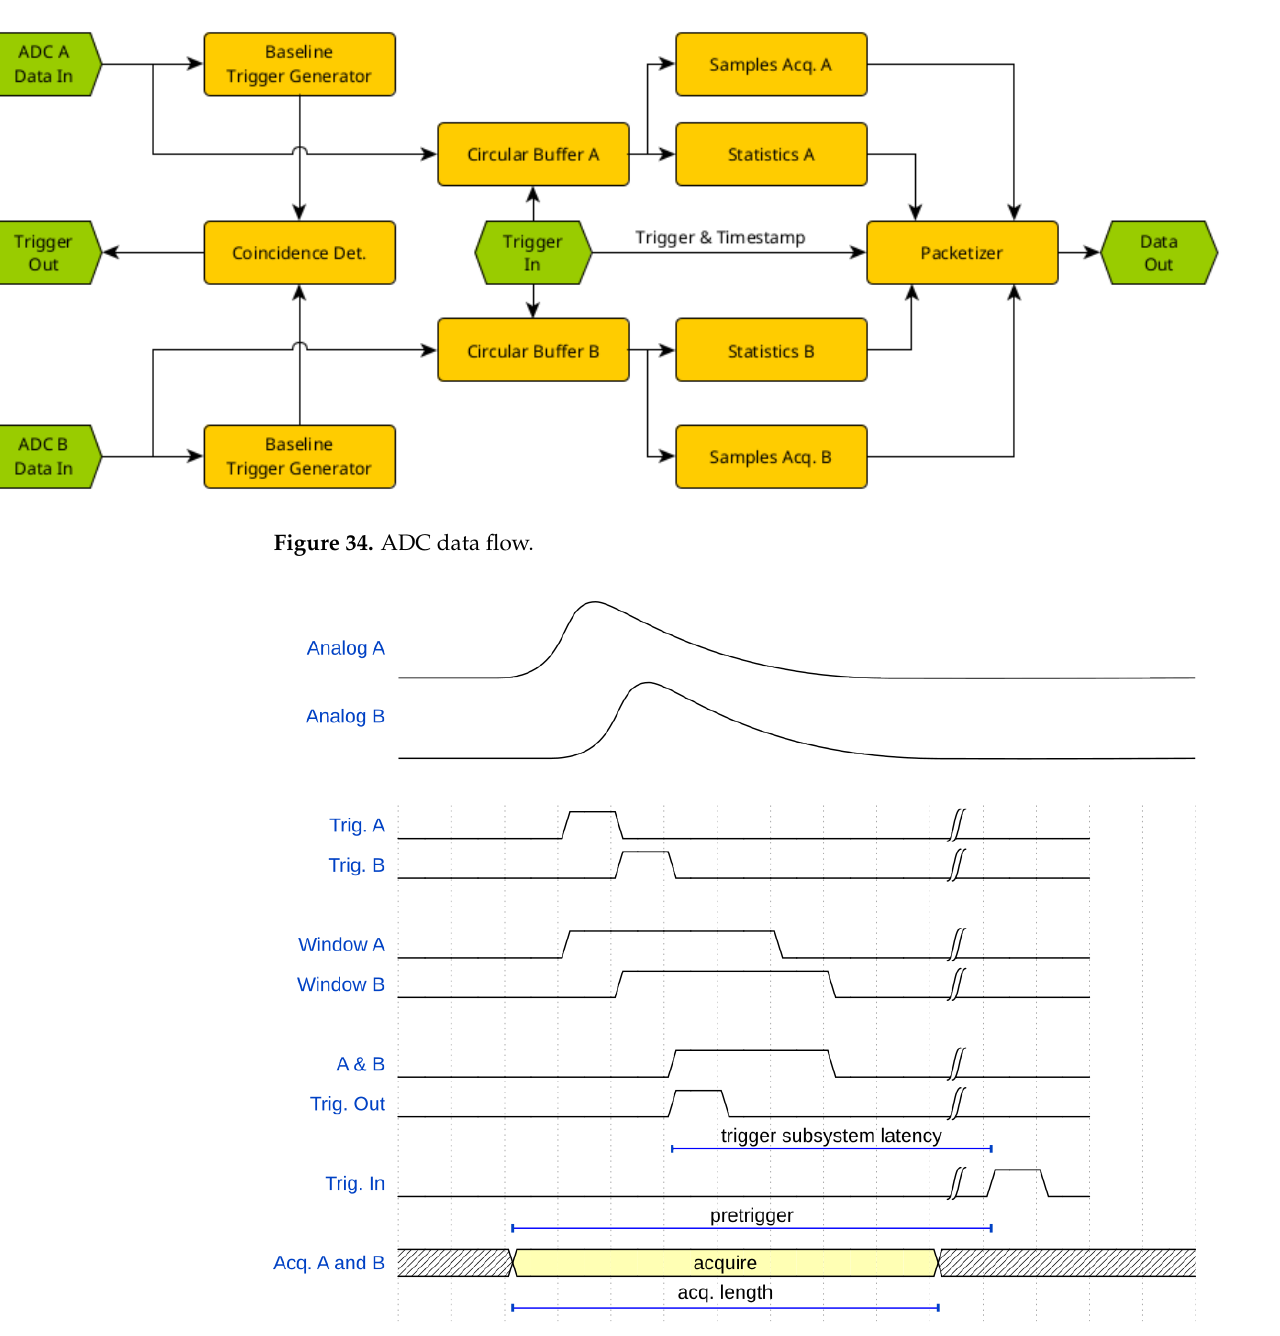
Figure 35. Coincidence detection for single detector